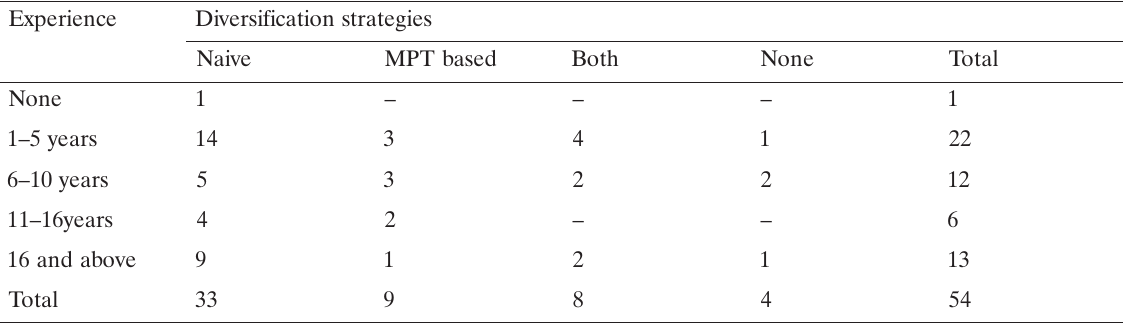
Table 7. The relationship between the practitioners’ year of post qualification experience and their choice of diversification strategies